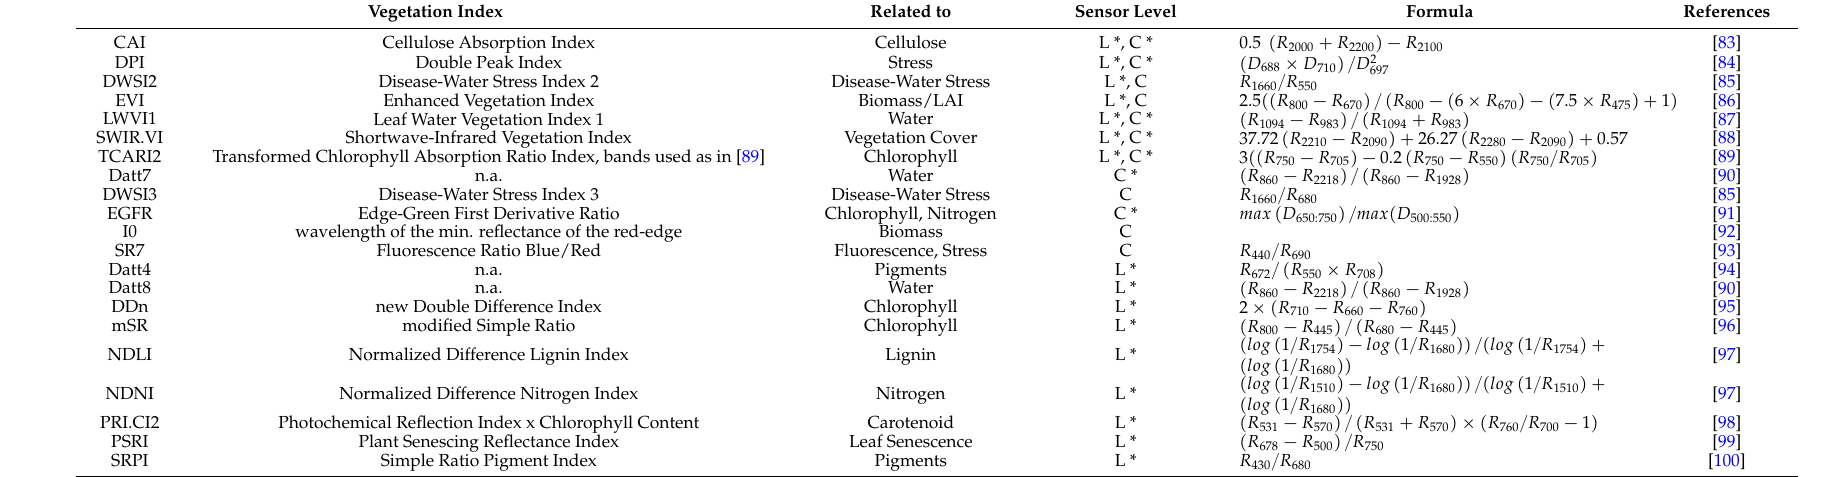
Table 3. Hyperspectral narrowband vegetation indices including related vegetation characteristics, the sensor level at which the index was applied (Leaf and Canopy) and spectral bands used for calculation. Significant differences ( p < 0.05, U-Test) in median index values between Acacia longifolia and adjacent dune vegetation are marked with an “*” for leaf and canopy scale,